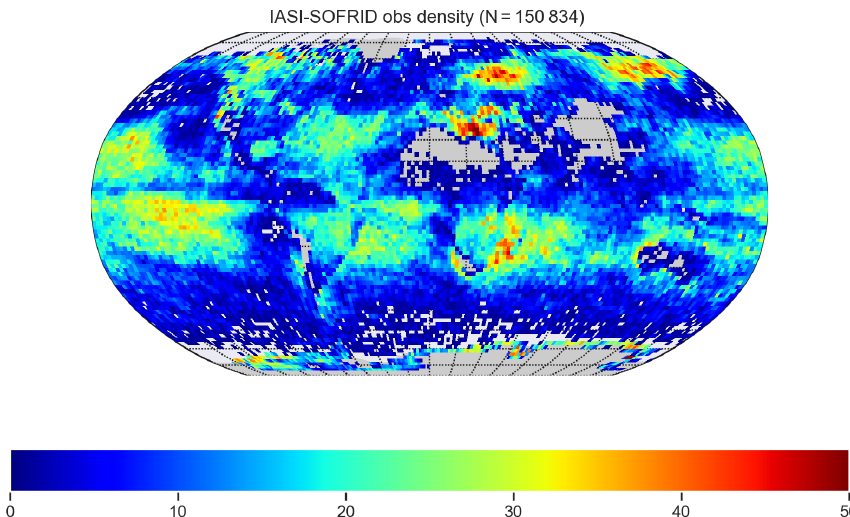
Figure 2. Total number of IASI observations per model grid box (2 ◦ × 2 ◦ ) retained after the selection procedure described in Sect. 2.4 and further assimilated in this study for the month of July 2010. The total number of assimilated observation for the entire globe (N) is given above the